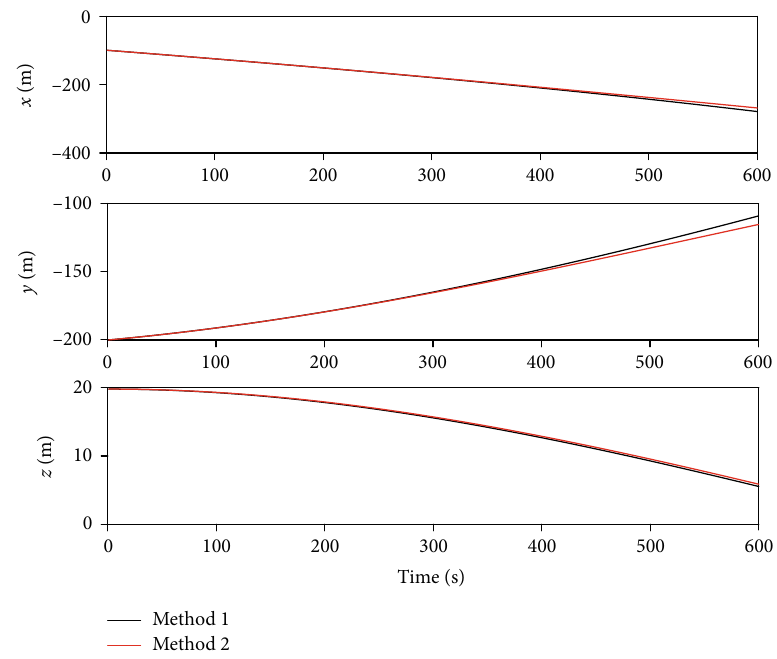
Figure 6: Schematic diagram of the position change of GEO satellites near the nominal position without